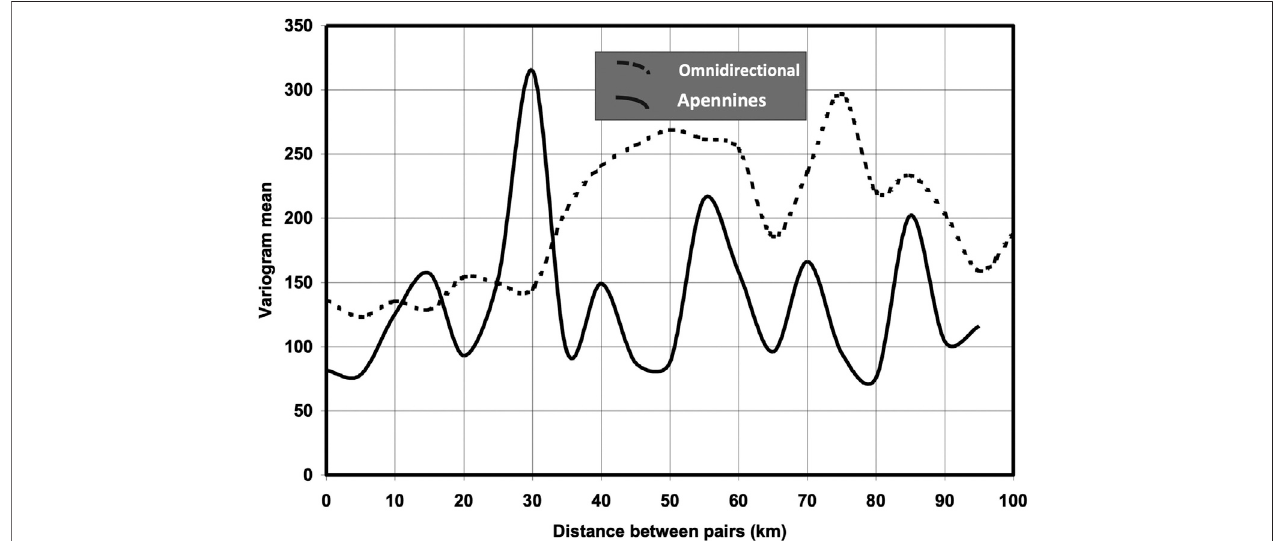
FIGURE 9 | Variogram of our selected thermal springs occurring in the latitude range 44.0 ° N to 40.0 ° N (see text and Supplementary Material for details). The continuousanddashed linesrepresenttheresultofananalysisperformedalongthestrikeoftheApenninesandalongtheaverageofallpossibledirections,respectively. The X axis reports the distance between pairs of springs, whereas the Y axis shows the value of the variogram function. The most signi fi cant peak is found along the function calculated along the Apennines trend at slightly less than 30 km distance.